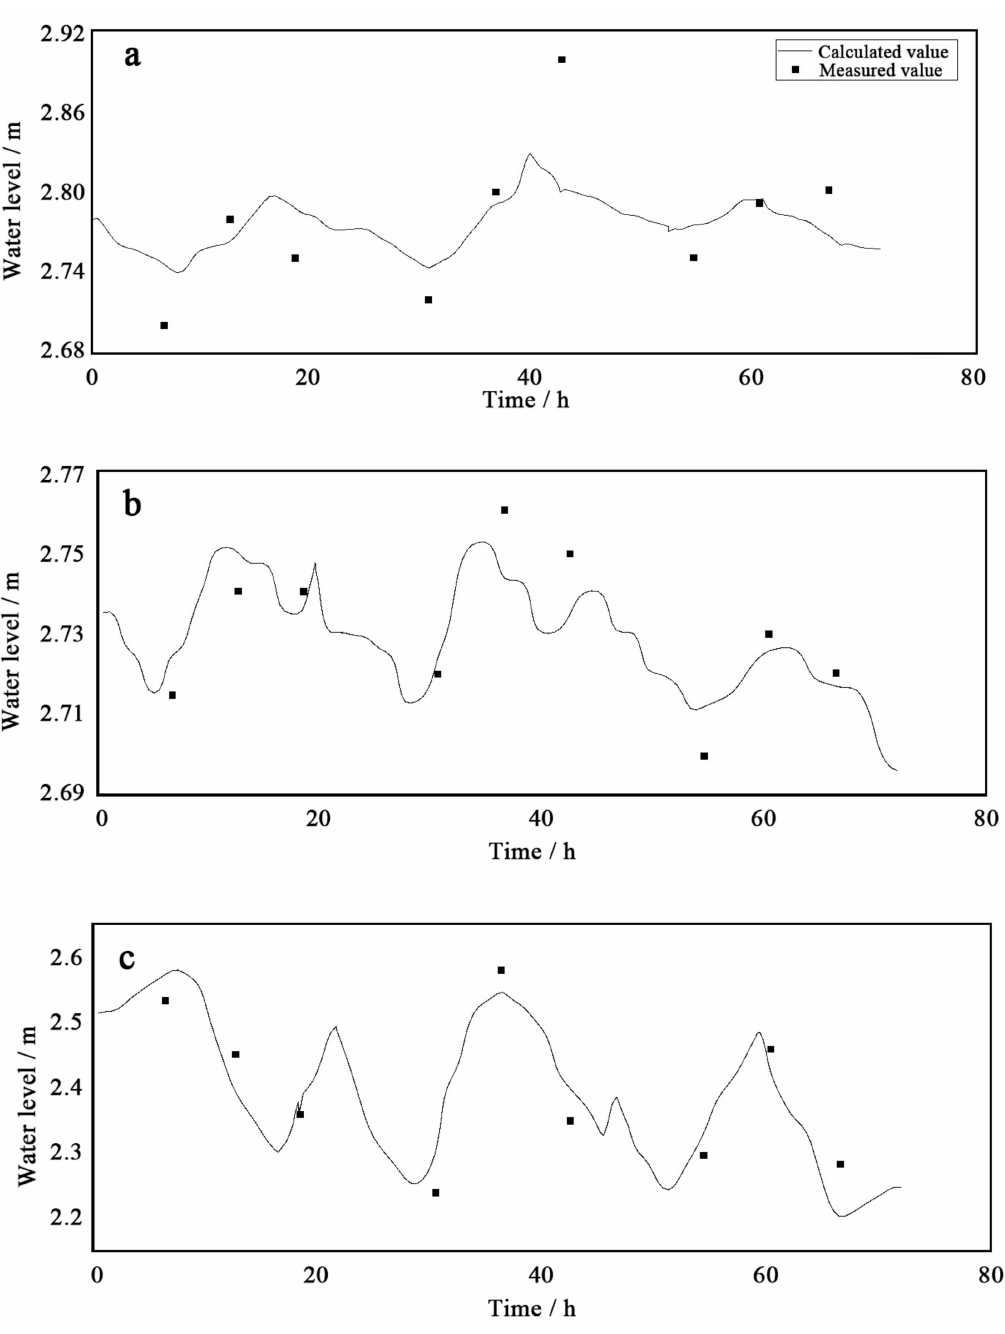
Figure 4. Comparison of calculated and measured water levels in each section in March (( a ). Taipu Gate; ( b ). Pingwang Bridge; ( c ). Liantang Bridge). Table 1. Calculated source strength and parameters related to the oil spill